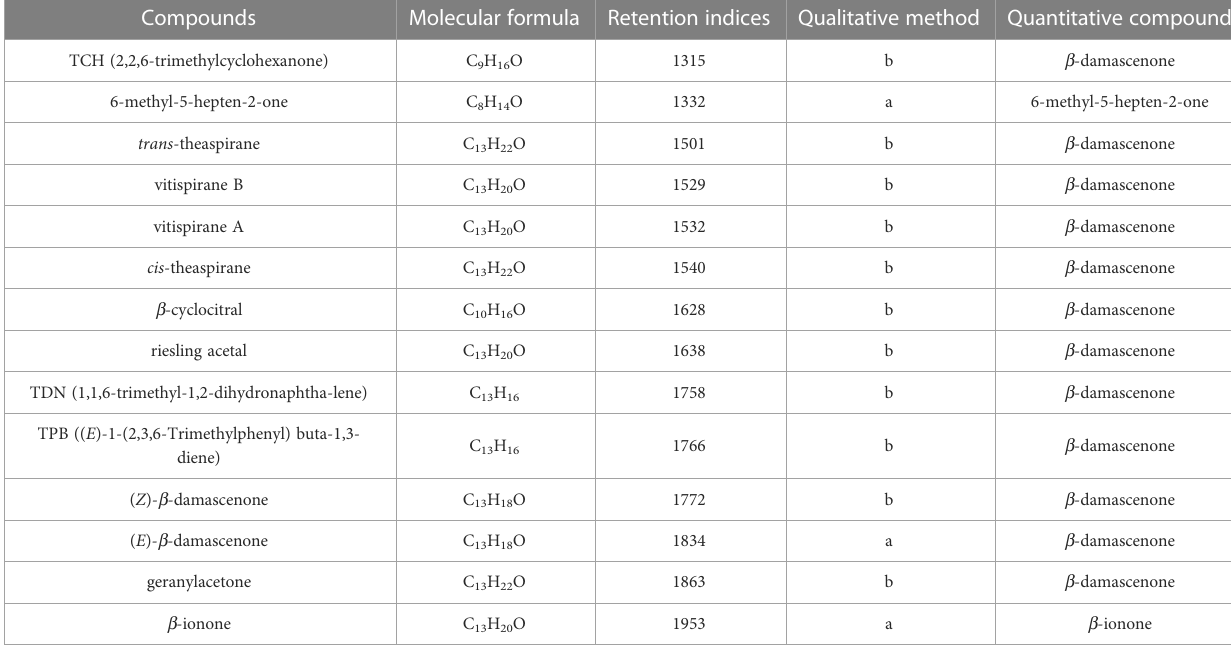
TABLE 1 Qualitative and quantitative information of norisoprenoid compounds detected in this